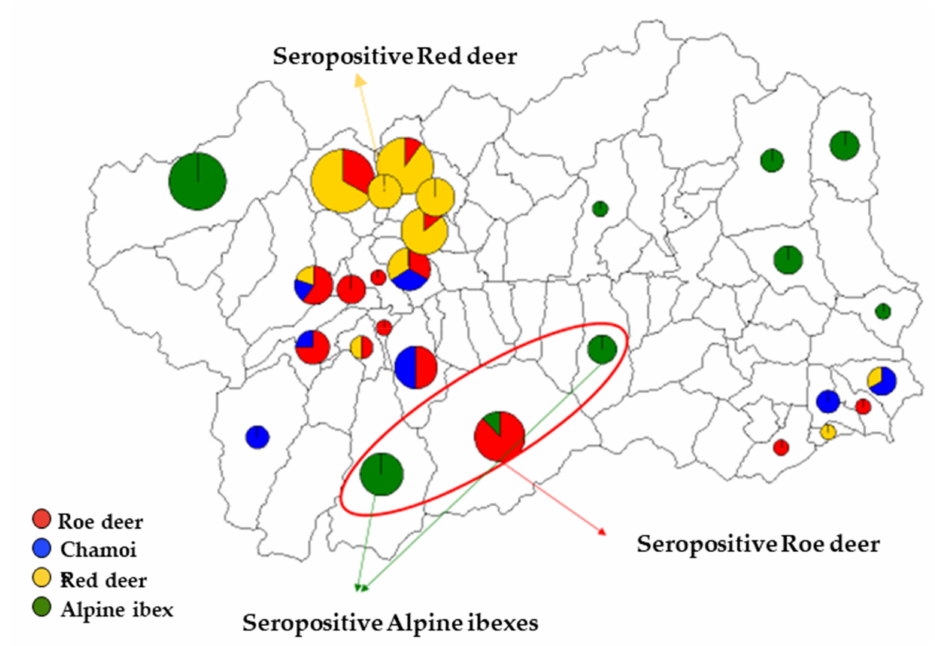
Figure 4. Maps of Valle d’Aosta Region showing the areas where seropositive wild ruminants were